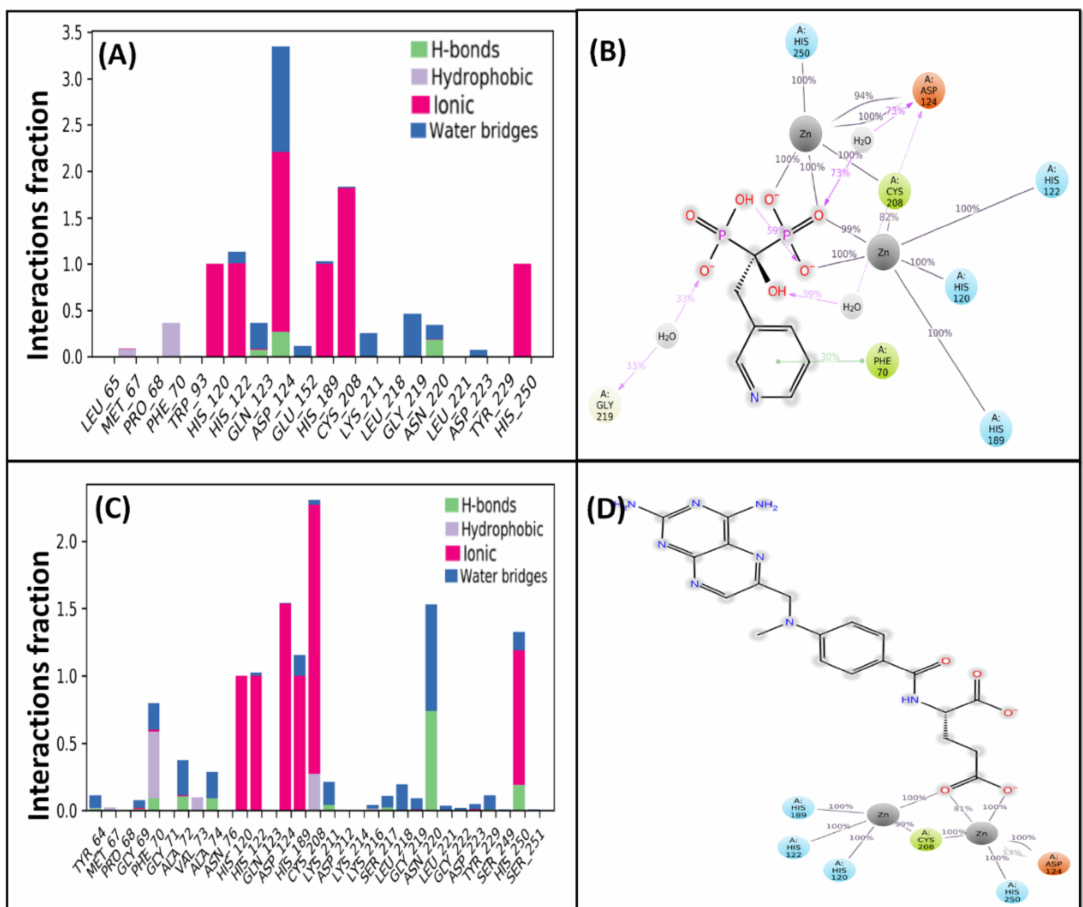
Figure 5. Interaction of NDM-1 with risedronate and methotrexate during MD simulation: ( A ) Interaction fraction of NDM-1 residues with risedronate, ( B ) Percentage of simulation time during which NDM-1 residues interacted with risedronate, ( C ) Interaction fraction of NDM-1 residues with methotrexate, and ( D ) Percentage of simulation time during which NDM-1 residues interacted with methotrexate.